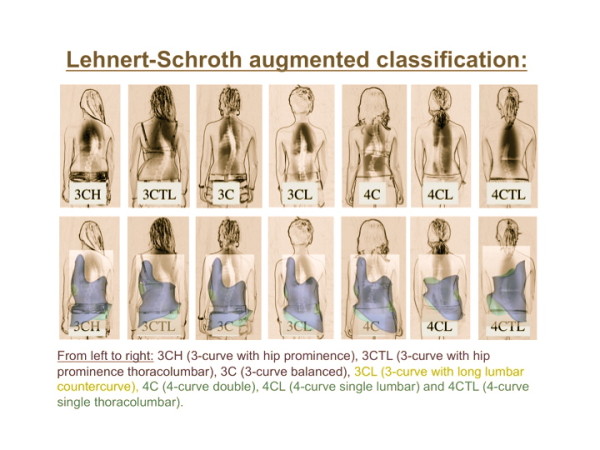
The ALS classification. (With kind permission by Pflaum, Munich).